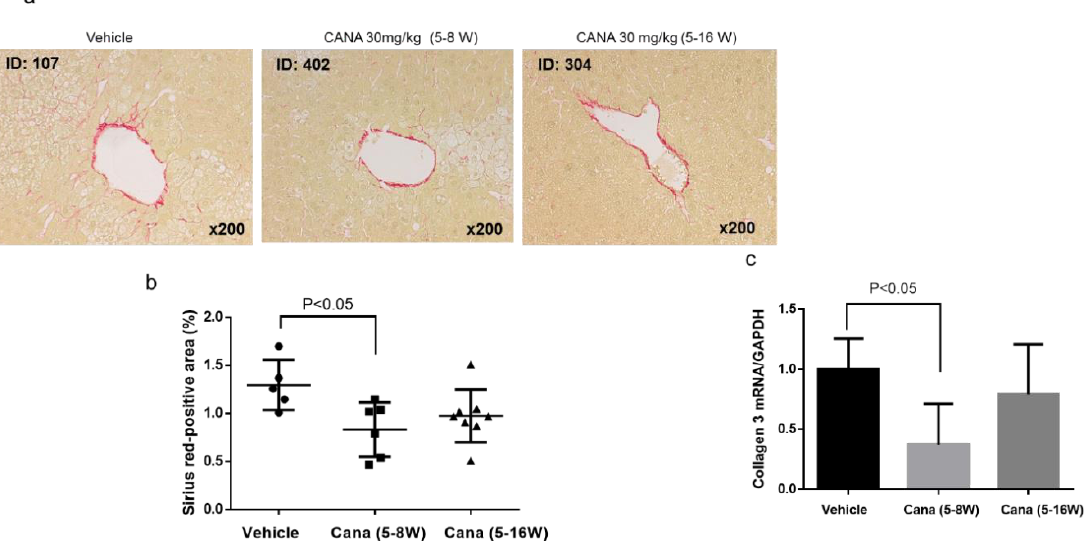
Figure 3. Representative microphotographs of liver sections stained with Sirius red in the liver sections ( a ) and percentage in area of positive staining for Sirius red in the three groups ( b ). ( c ) mRNA expression of collagen 3.